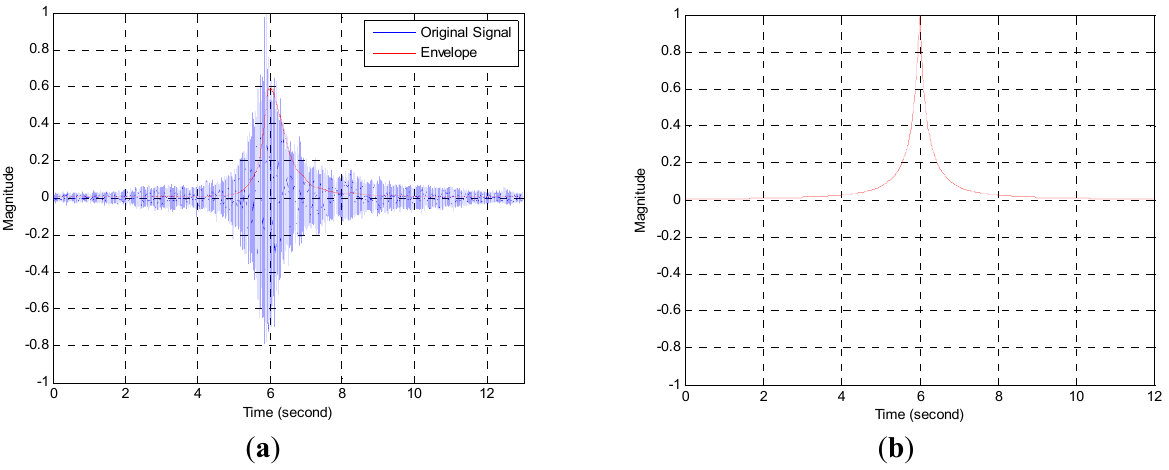
Figure 2. ( a ) Simulated field signal and corresponding envelope; ( b ) Simulated envelope from ISL (10 km/h and 100 Hz sampling frequency).